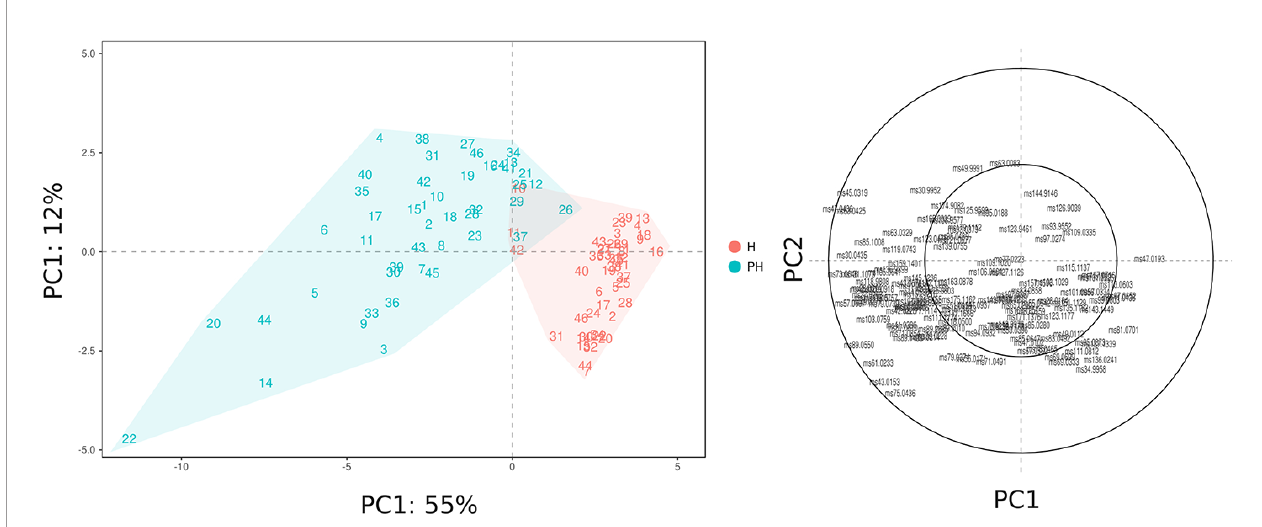
FIGURE 5 | PCA and loading plot of the VOC pro fi le of 46 Vaccinium spp. cultivars, assessed by PTR-ToF-MS at harvest and after storage. Each point of the PCA plot is the average of three